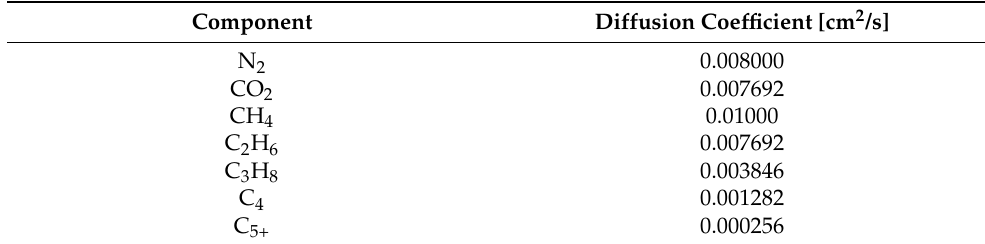
Table 4. Diffusion coefficients of different